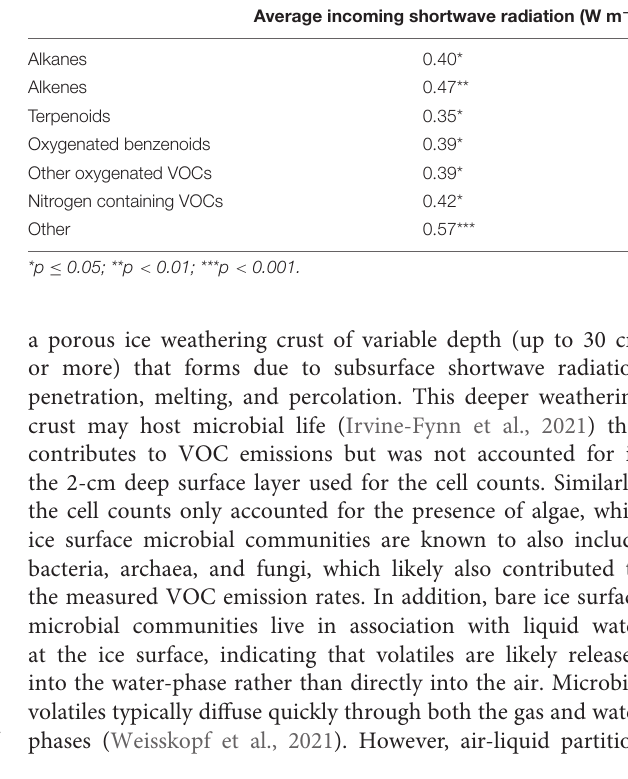
Frontiers in Microbiology |